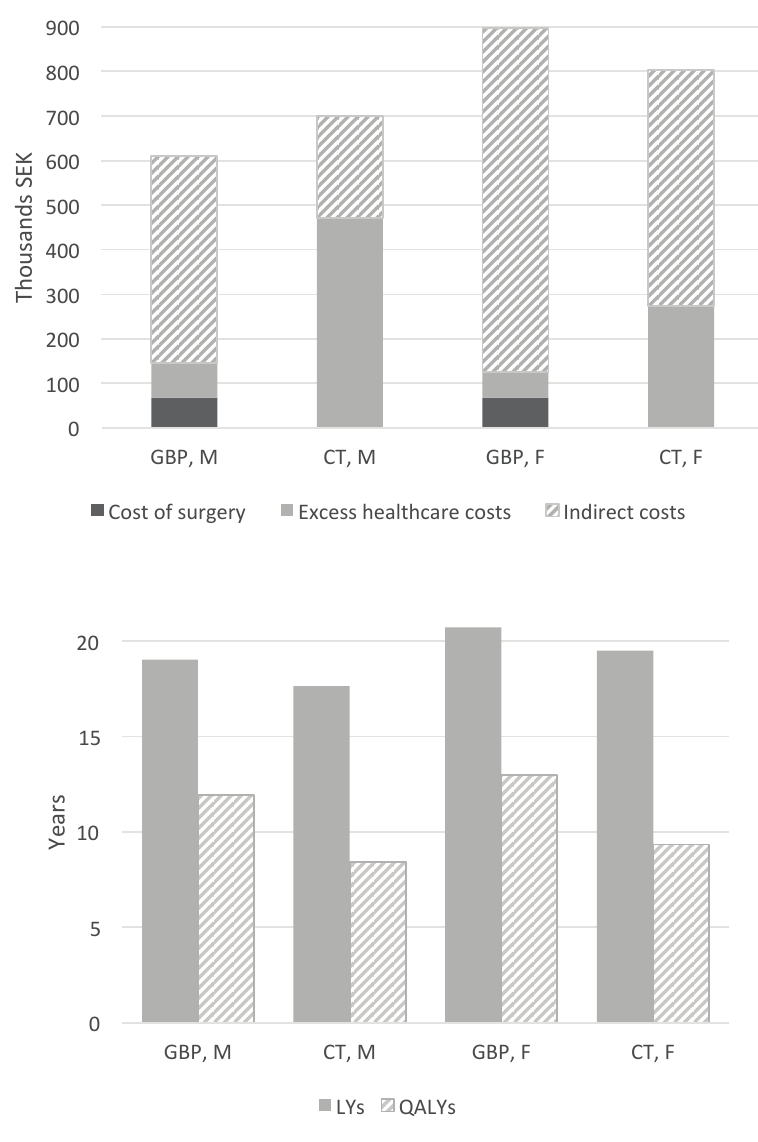
Figure 4: Costs, life years and QALYs Predicted costs of surgery (black), excess healthcare costs (grey) and indirect costs (dashed); and Life years (LY, black) and QALYs (dashed), per patient by gender (M/F) given Gastric Bypass surgery (GBP) or Conventional Treatment (CT). Costs presented in year 2012